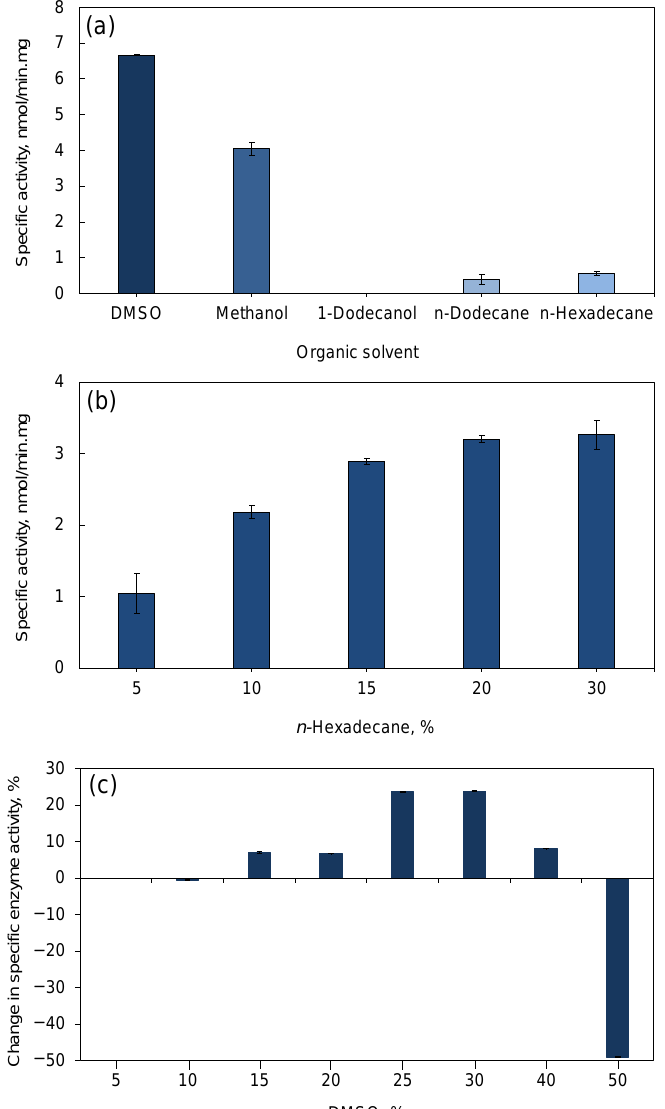
Figure 2. Effect of organic solvents on TR 8 transaminase activity: ( a ) activity in the presence of miscible and immiscible solvents; ( b ) activity in the presence of 5 to 30% ( v/v ) n- hexadecane; and ( c ) change in enzyme activity at different DMSO concentrations relative to 5% ( v/v ) DMSO.